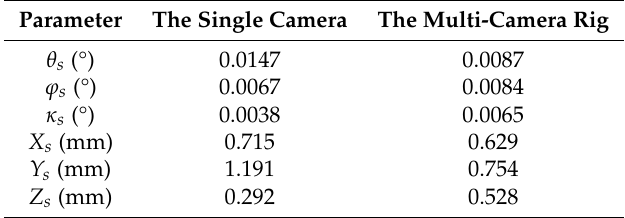
Table 1. Measurement accuracy comparison between the single camera and the multi-camera